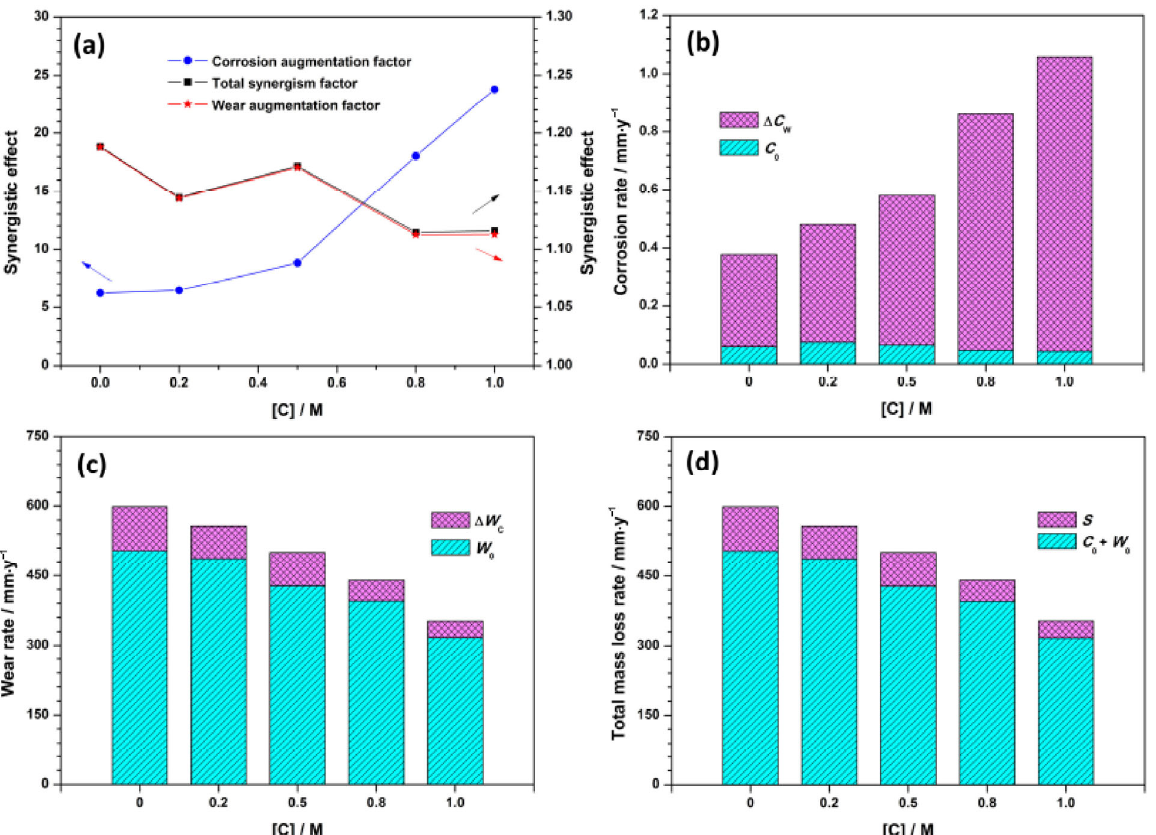
Fig. 9 Synergistic contributions of wear and corrosion of NAB alloy in seawater with different halide